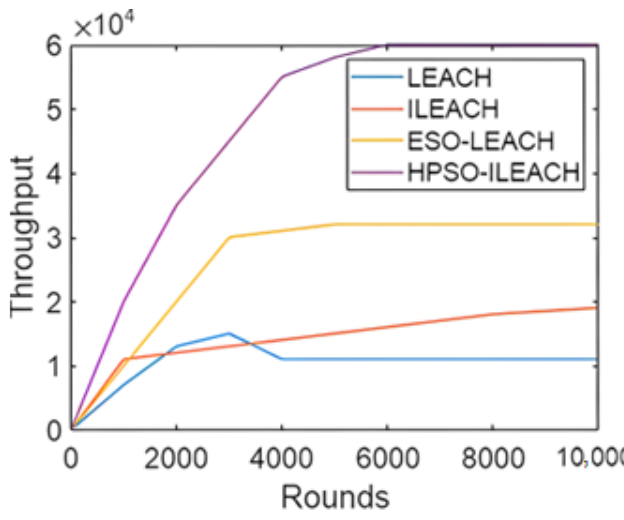
Figure 11. Throughput (CHs to BS).